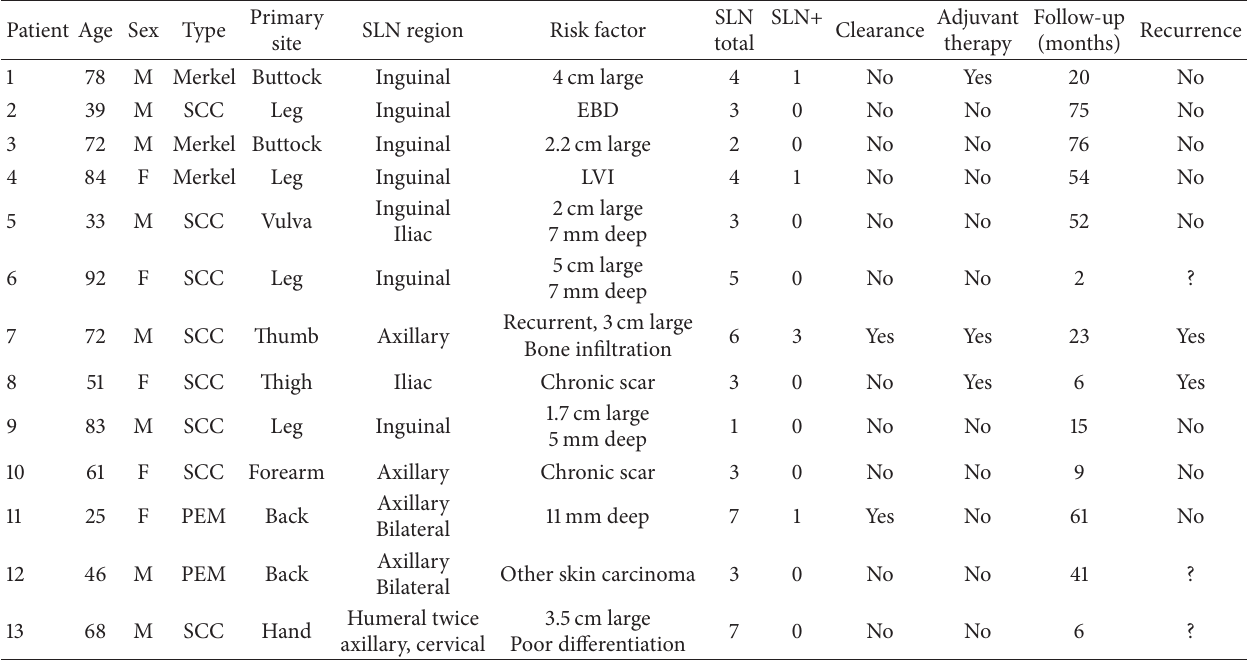
Figure 1: Patient 13 had a 3.5 cm large poorly differentiated SCC on the dorsal side of left hand that was reaching subcutaneous level with perineural invasion but with no lymphovascular invasion. Dynamic lymphoscintigraphy of the upper left limb demonstrated multiple drainage pathways on the dynamic views (a), and accessories lymph nodes were immediately visualized in the humeral lateral and medial regions (red arrows). These were confirmed not to be only ectatic lymphatic vessels but 2 different sentinel nodes corresponding to 2 basins (b). Delayed views of the arm and shoulder (c, d) showed 2 more SNs in 2 basins: in the axilla (blue arrow) and basicervical (green arrow). All 7SNs in 4 basins were negative. Table 1: Patient characteristics, sentinel lymph nodes results, and